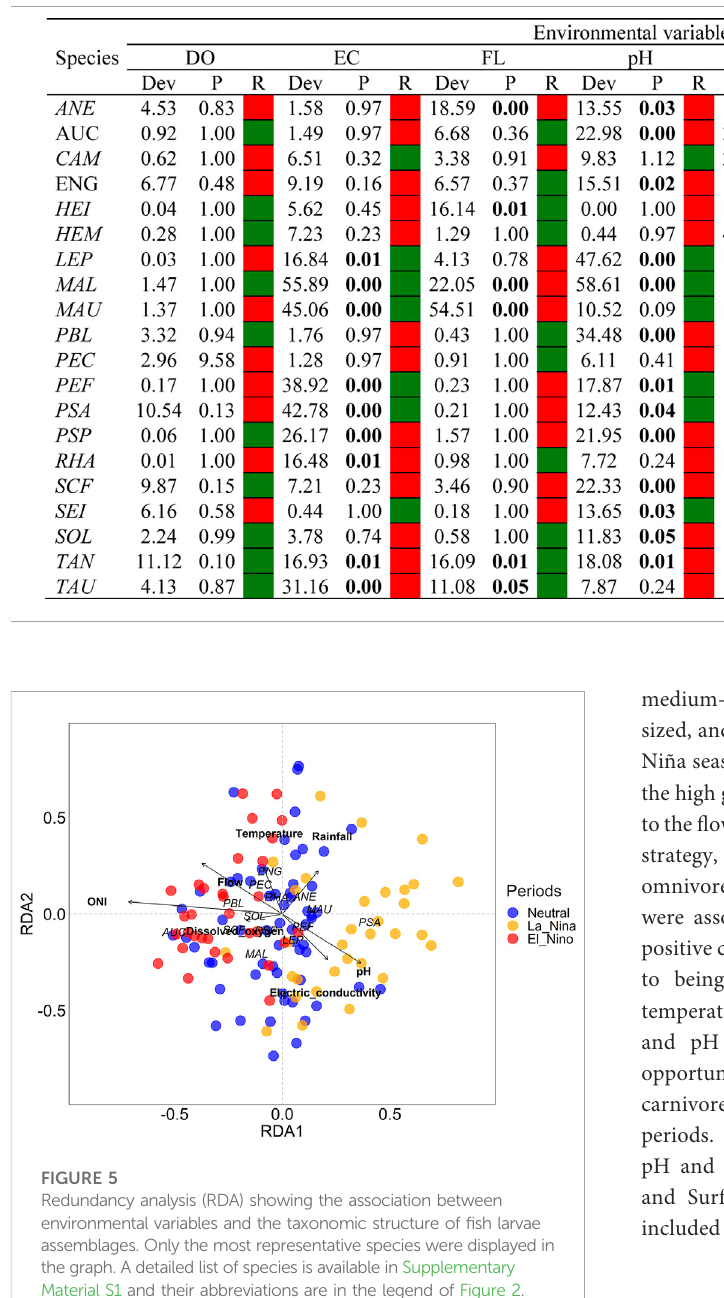
TABLE 2 Summary of GLM for the effects of environmental variables and periods on the taxonomic structure of fi sh larvae assemblages in the Lower Amazon.DO = Dissolved Oxygen, EC = Electrical Conductivity, FL = Flow, pH = Hydrogenonic Potential,ONI = Oceanic Niño Index, RF = Rainfall, TE = Temperature, A = association with the neutral period (color blue), El Niño (color black) and La Niña (color yellow). R = type of positive (color green) or negative (color red) relationship with the environmental variable. Values in bold indicate signi fi cance (p < 0.05). The abbreviation of the species names can be found in the legend of Figure 3.